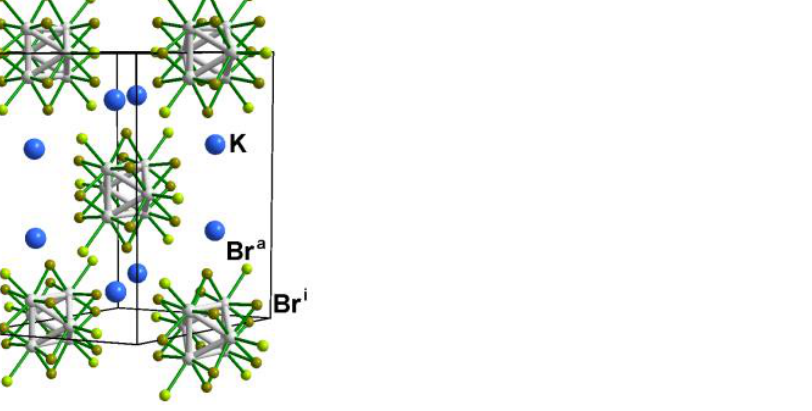
Figure 1. Perspective representation of the unit-cell of K 4 [{Ta 6 Br i 12 }Br a 6 ] evidencing the stacking of the [{Ta 6 Br i 12 }Br a 6 ] 4 − cluster building blocks and the potassium